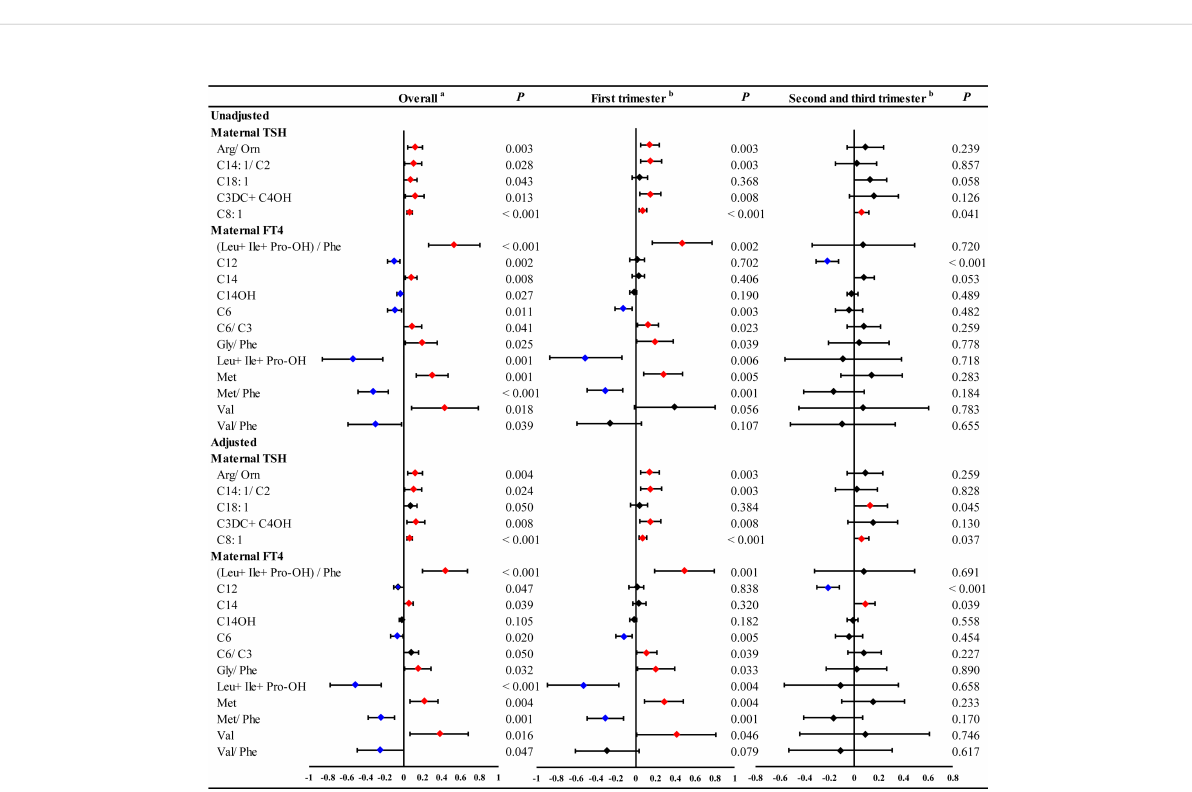
FIGURE 1 The signi fi cant linear ausociations of maternal serum THs with part of neonatal metabolites during overall pregnancy or at different trimesters. GLM Model a adjusted by the age of pregnant women, gestational weeks at sample collection, newborn birth weight and gestational age at delivery. GLM Model b adjusted by the age of pregnant women, newborn birth weight and gestational age at delivery. Red and blue dots indicate signi fi cant positive and negative correlations, respectively.